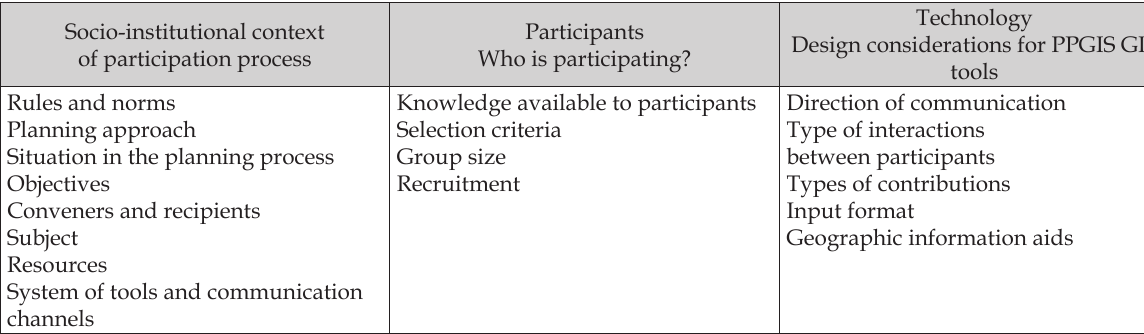
Table 2. Proposed dimensions of PPGIS design (by M. Czepkiewicz et al.).